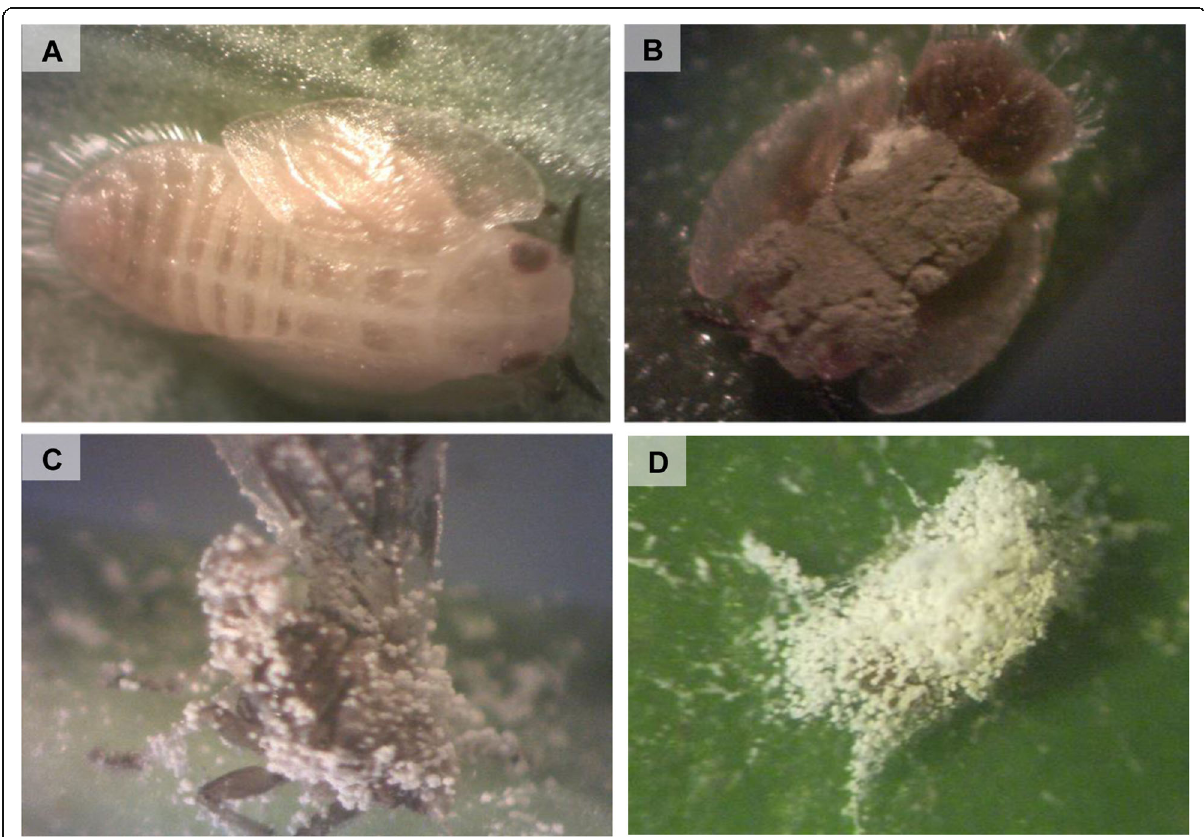
Fig. 1 Fungal infection of Diaphorina citri. a Control nymph of Diaphorina citri . b Nymph with Metarhizium anisopliae 2411. c Adult with Beauveria bassiana 2067. d Nymph with B. bassiana 2067